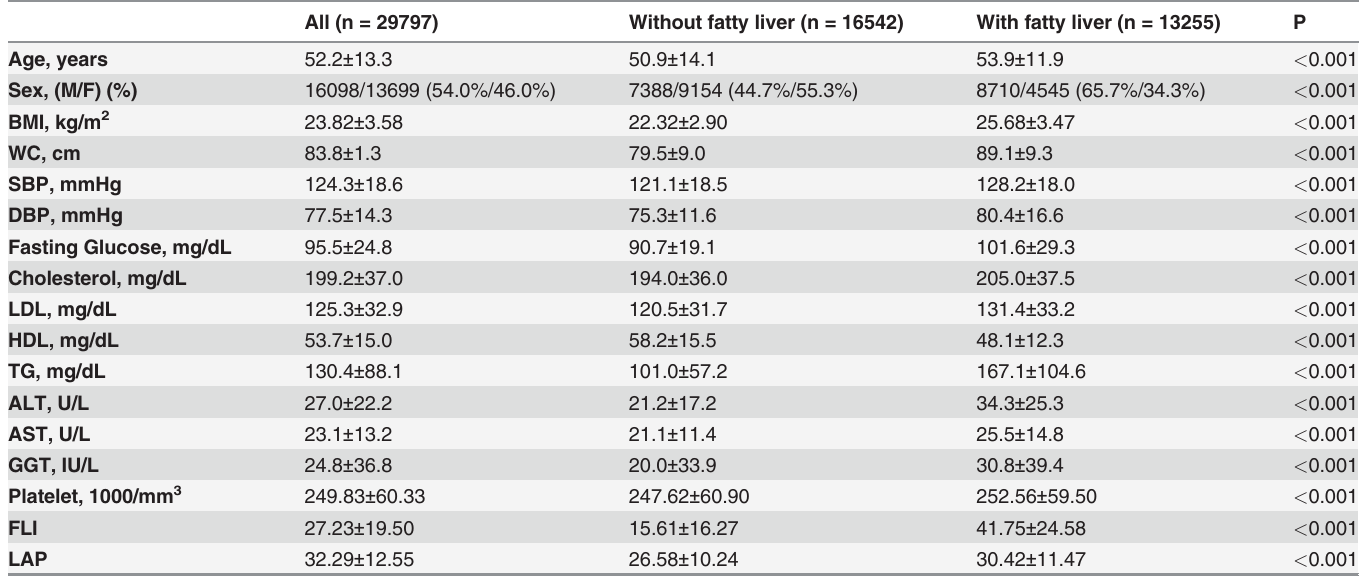
Table 1. Comparison of demographic characteristics between subjects with and without ultrasonogrphic fatty